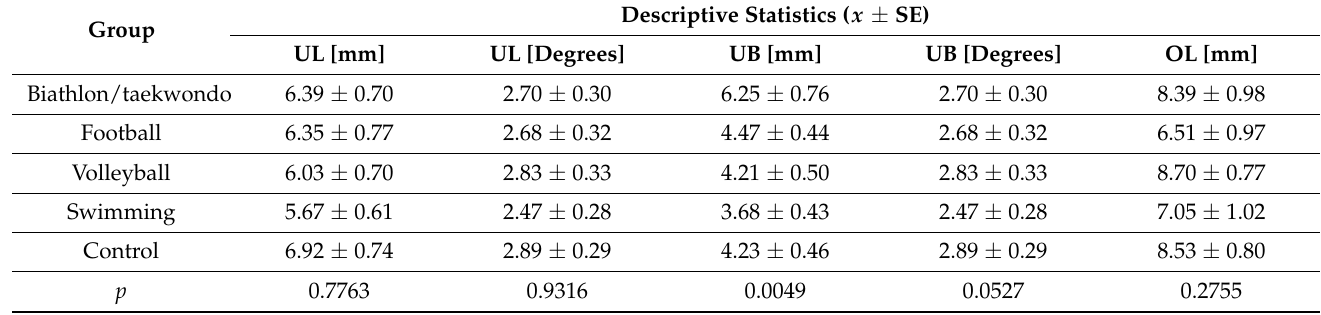
Table 4. Characteristics of the UL, UB, and OL